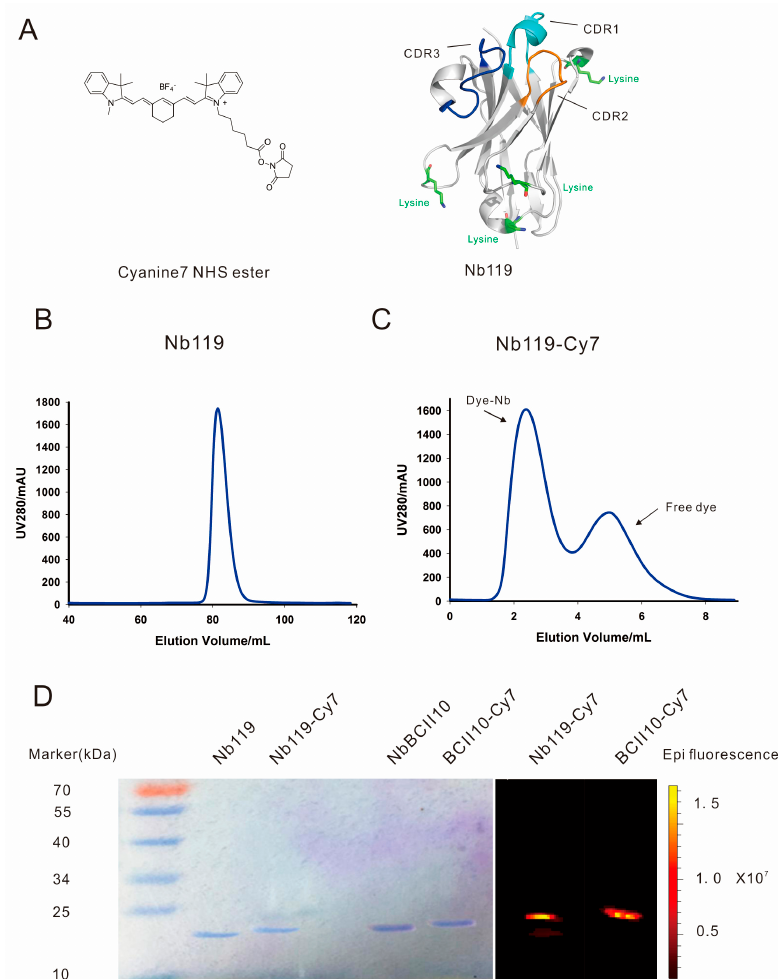
Figure 2. Purification and purity study of Nb119 Cy7 conjugates. ( A ) Schematic representation of Cyanine 7 NHS ester (Cy7) and Nb119 protein structure CDR1 in Cyan, CDR2 in blue and CDR3 in orange, the 4 lysines in the framework region are indicated in green. ( B ) Superdex 75 purification of Nb119. ( C ) Superdex 75 purification of Cy7 conjugated Nb119; dye-conjugated nanobody and free dye are indicated. ( D ) Coomassie-stained gel and NIRF image of unconjugated Nb119, BCII10 and respective Cy7 conjugated nanobody.